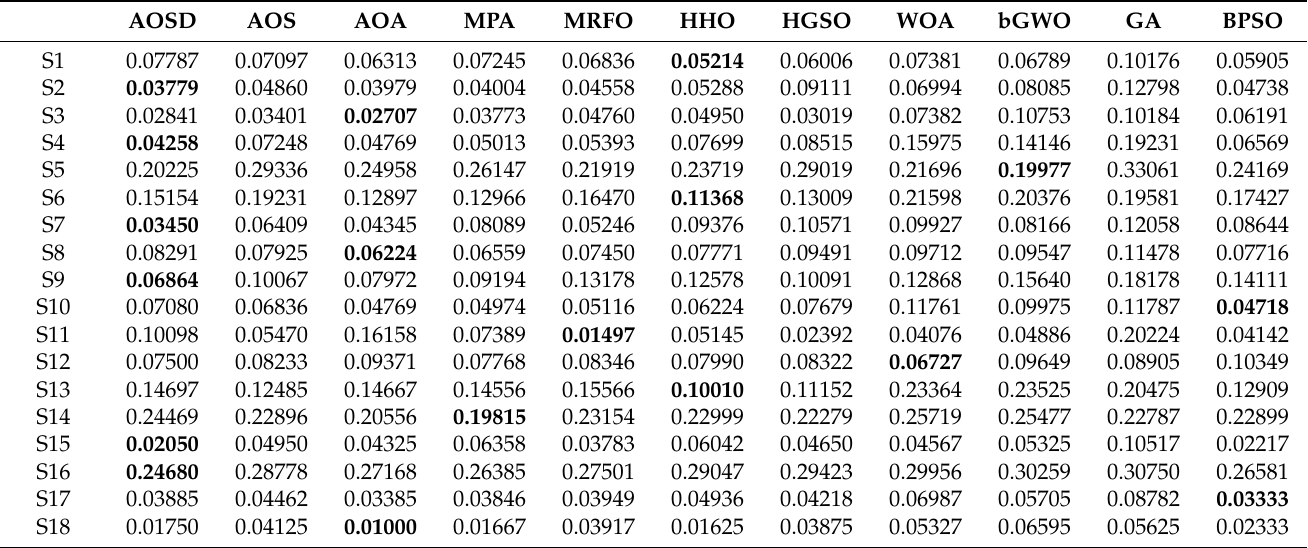
Table 3. Average of the fitness values for FS